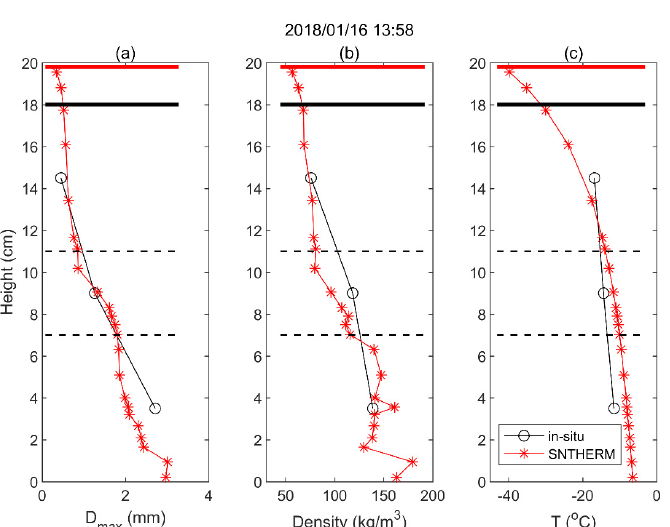
Figure 3. Comparison of the vertical profiles of snow parameters on 16 January 2018 between the SNTHERM simulations and Altay in situ measurements: ( a ) geometric grain size ( D max ); ( b ) snow density; and ( c ) physical temperature (T).